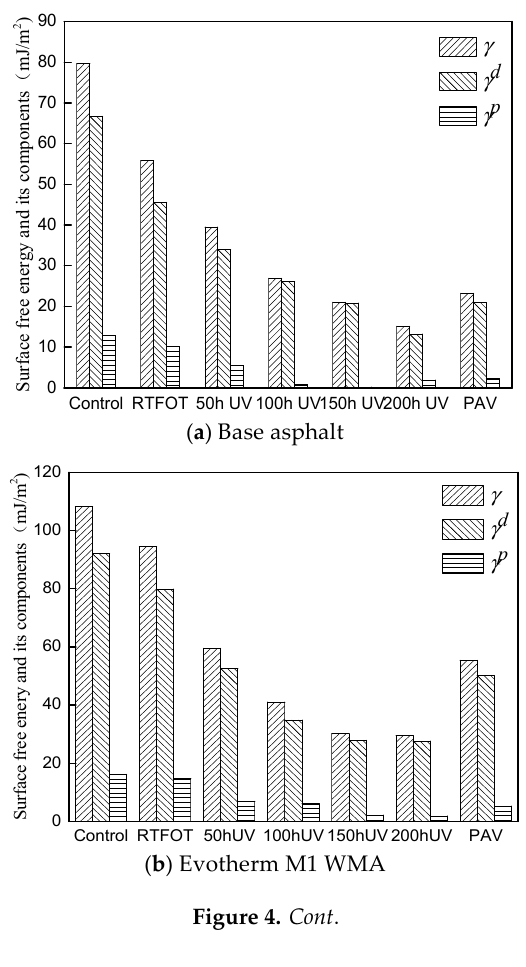
( b ) Evotherm M1 WMA Figure 4. Cont